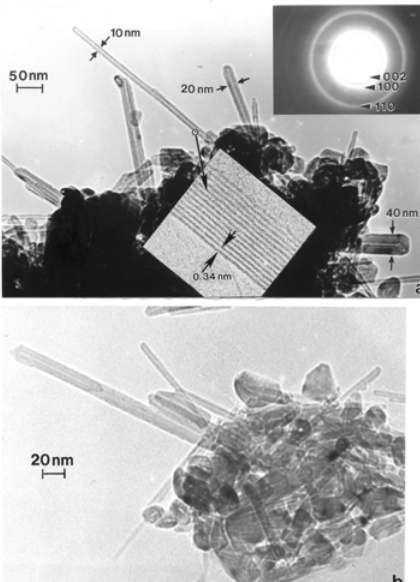
Figure 9: TEM images for MWCNT aggregates containing faceted, polyhedral structure. (a) Natural gas (flame) produced. SAED pattern show graphitic reflections noted while the high resolution image insert shows 13 concentric nanotube layers. (b) Propane truck exhaust MWCNT, multiconcentric fullerene aggregate collected by thermal